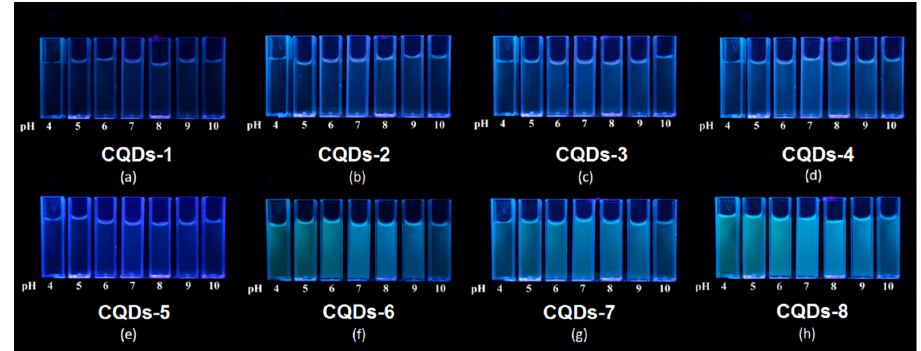
Figure 10. Images of the prepared CQDs’ fluorescence dependence on solvent pH value (excitation